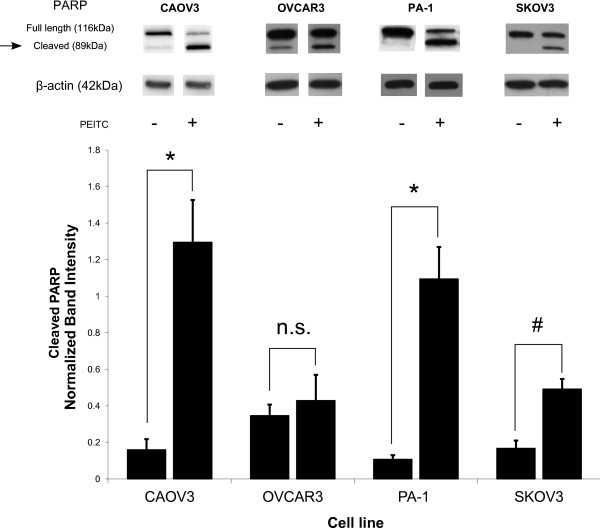
Cause of cell death for PEITC treated cells. PARP cleavage is increased by treatment with PEITC in multiple ovarian cancer cell lines, indicating death by apoptosis. Western blot for full length and cleaved PARP after 48 hours of treatment is displayed. Blots are representative images of band intensity. Bar graph represents cleaved PARP band intensity normalized to β-actin. * p < 0.01, # p < 0.05, n.s. = not significant.